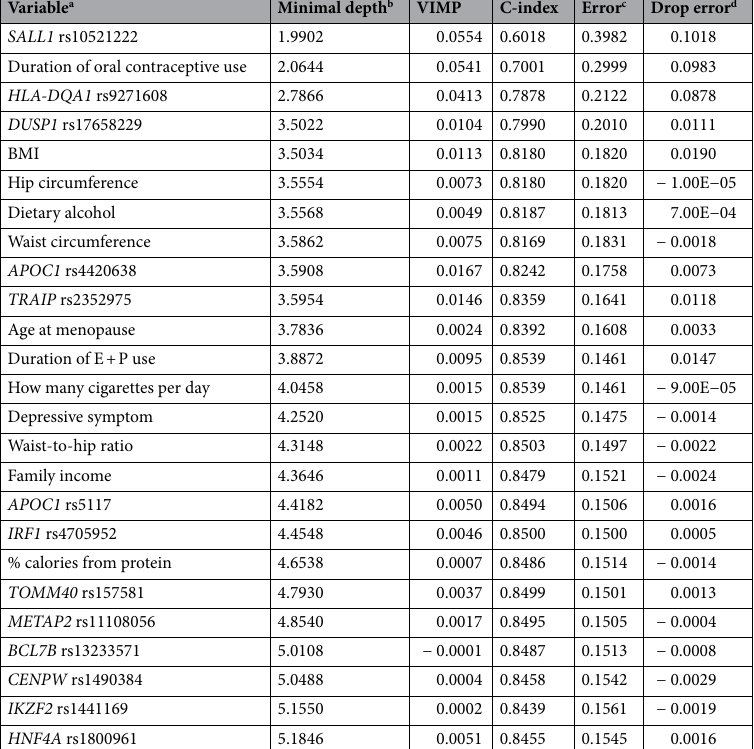
Table 2. The second stage of random survival forest analysis: predictive value of variable for breast cancer in overall analysis. BMI, body mass index; C-index, concordance index; E + P, exogenous estrogen + progestin; VIMP, variable of importance. a Variables are ordered by minimal depth. b Predictive value of variable was assessed via minimal depth in the nested random survival forest models. A lower value is likely to have a greater impact on prediction. c The incremental error rate of each variable was estimated in the nested sequence of models starting with the top variable, followed by the model with the top 2 variables, then the model with the top 3 variables, and so on. For example, the 3rd error rate was estimated from the 3rd nested model (including the 1st, 2nd, and 3rd variables). d The drop error rate was estimated by the difference between the error rates from the nested models with a prior and the corresponding variable. For example, the drop error rate of the 2nd variable was estimated by the difference between the error rates from the 1nd and 2rd nested models. The error rate for the null model is set at 0.5; thus, the drop error rate for the 1st variable was obtained by subtracting the error rate (0.3982) from